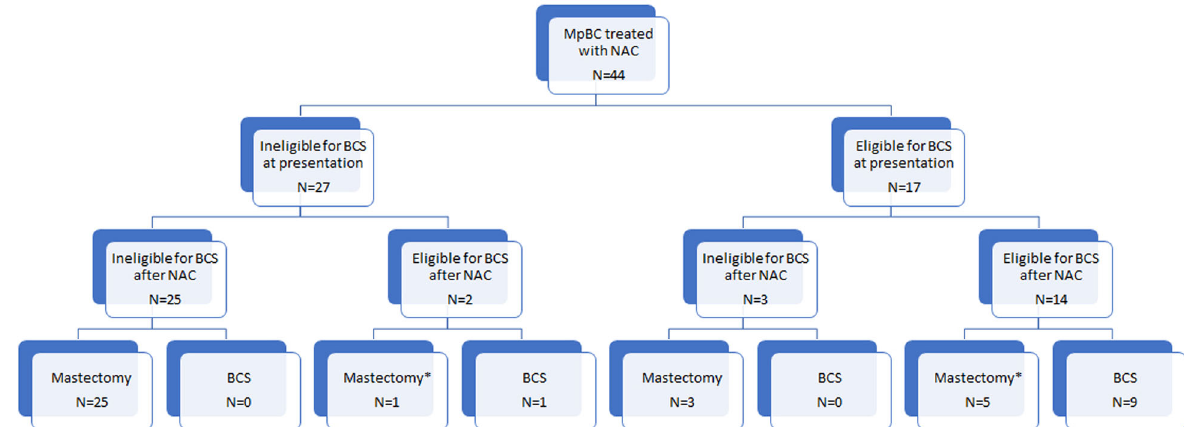
Fig. 1 Flow chart of surgical treatment. MpBC metaplastic breast cancer, NAC neoadjuvant chemotherapy, BCS breast conversing surgery. *Patient ’ s